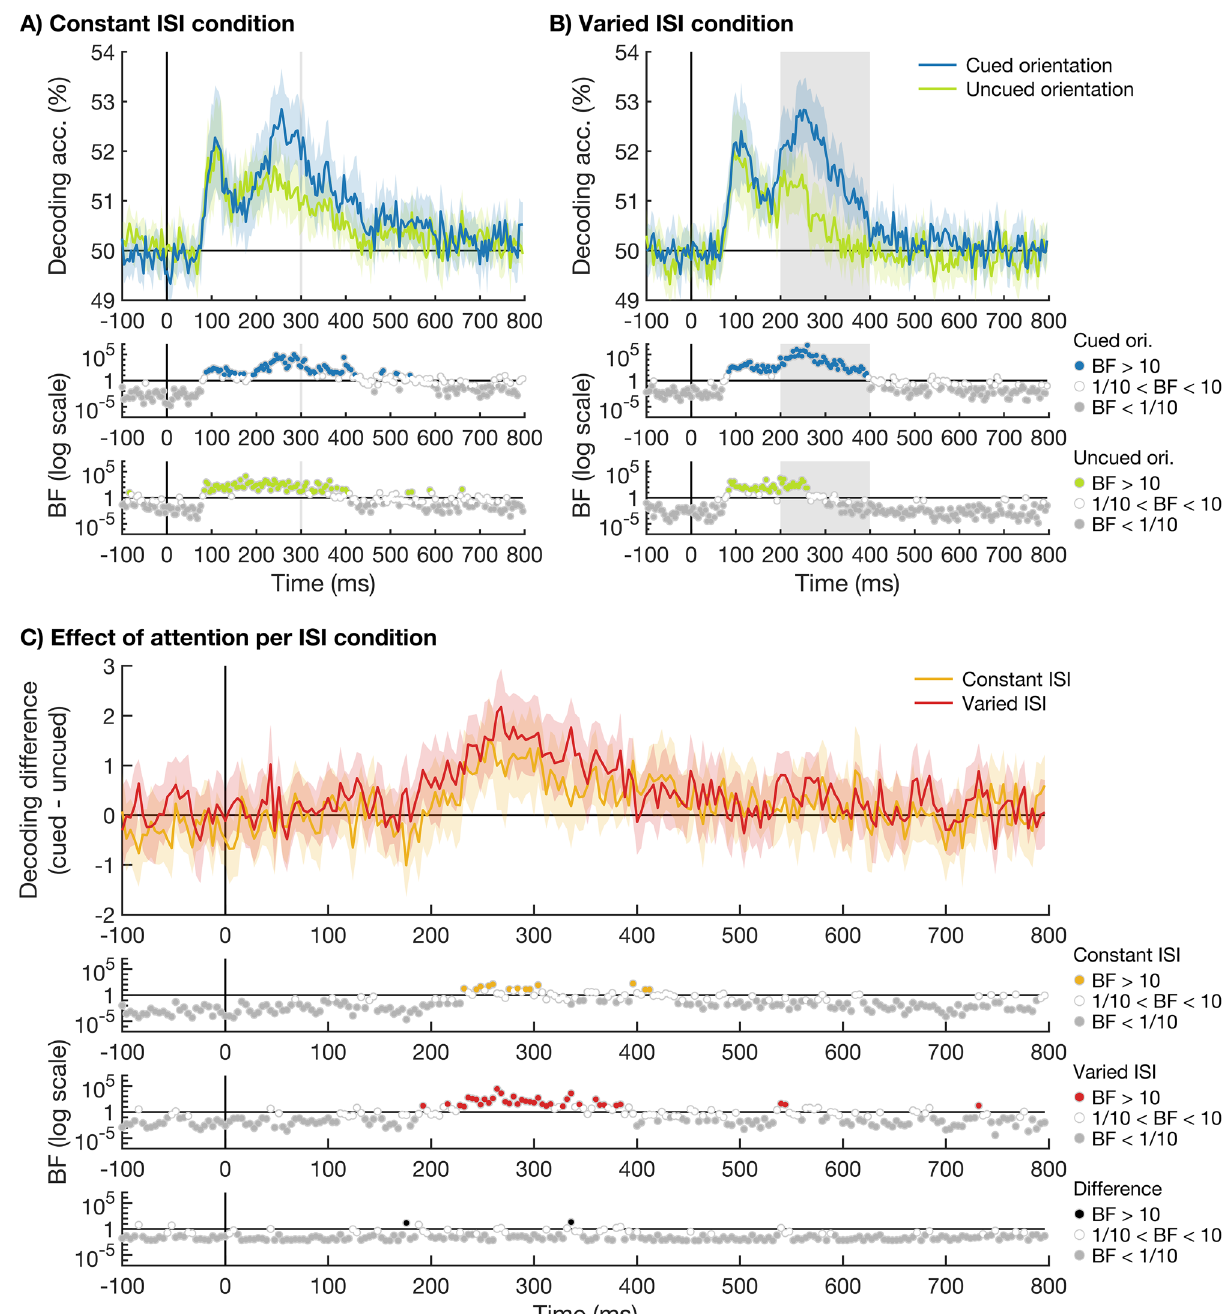
Figure 4. Time-course of decoding accuracies of the cued and uncued orientations for the varied and constant ISI conditions. Plots show the decoding accuracies of the cued (blue) and uncued (light green) stimulus orientation over time for the constant ISI condition in ( A ) and the varied ISI condition in ( B ). The possible onset time(s) of the next stimulus in the sequence are indicated by a grey shaded line at 300 ms in ( A ) and a grey shaded area between 200 and 400 ms in ( B ). ( C ) shows the effect of attention on stimulus coding, calculated as the difference in decoding accuracy for the cued and uncued conditions, for the constant ISI condition (yellow) and the varied ISI condition (red). We observed an effect of attention for both timing conditions, starting at 248 ms after stimulus onset for the constant ISI condition, and at 232 ms after stimulus onset for the varied ISI condition. We directly compared the effect of attention for the 2 different ISI conditions and found no 2 consecutive time-points with BF 10 > 10. Plotting conventions are the same as in Fig.